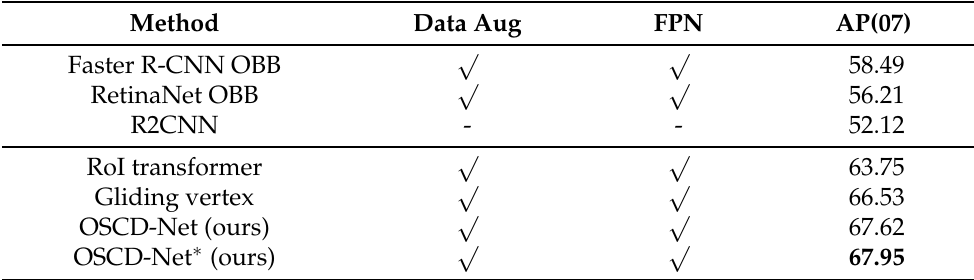
Table 5. Performance evaluation of nine different methods on DOTA-Ship dataset. The highest value is indicated by bold numbers